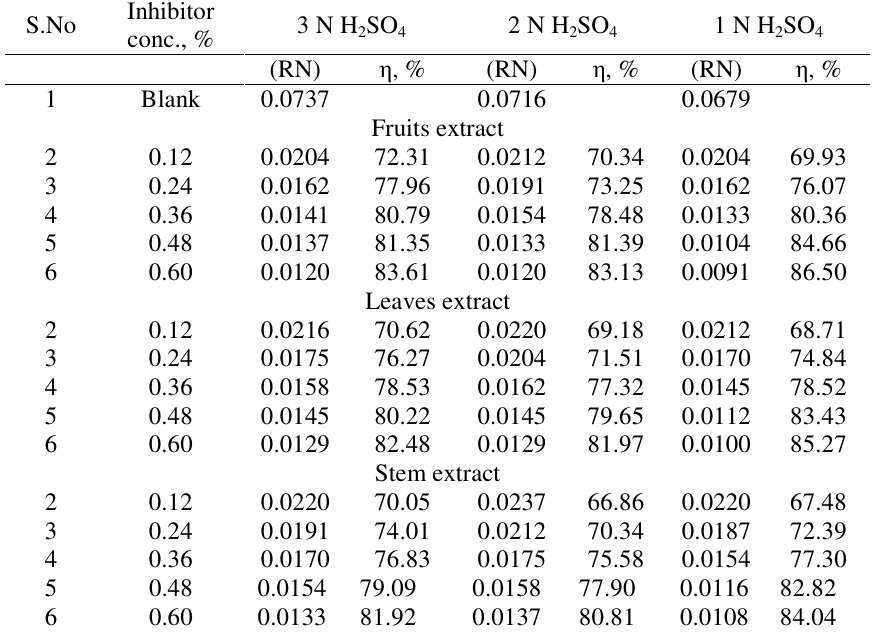
Table 2. Reaction number (RN) and inhibition efficiency ( η %) for mild steel in H 299±0.2 K with alcoholic extract of plant Cordia dicotoma (Area of exposure – 7.75 cm 2 Time of exposure – 24 h)